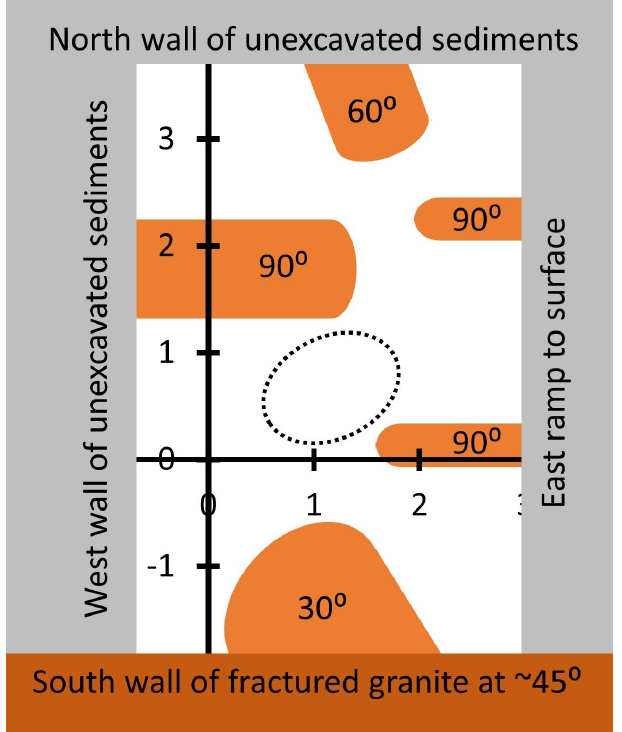
Figure 10. The layout of granite rocks (brown) and sediment walls (gray) at depth of ~ 6.3 to 6.5 m. The scale is in meters and the angles are between the vertical and the normal to the largest-area surface. The origin is directly below the center of the original impact crater on the surface with an estimated accuracy of +/- 0.3 m. The dotted ellipse shows the approximate projection of the shat- tered rock found in the 2018 excavation at 4.7-m depth to the 6.4-m depth shown here. We could not determine whether the mixture of rocks and slabs at different angles to the horizontal, as shown in Figure 10, were characteristic of the site before the 1985 event or were caused by that event. Additional excavation directly beneath the grouping of fractured rock at ~4.7-m depth was blocked by large boulders or displaced slabs around that volume. These obstacles were too large to move with available equipment. In addi- tion, the excavation from 4.8 m to 6.3 m had nearly vertical walls, which introduced a safety risk and precluded more excavation within the limitations of the project. 3.6. Potential for Independent Validation of the 1985 Event The force equation for a high-velocity body with instantaneous radius r m , mass m , and velocity v , moving through a fluid of density ρ p with a drag coefficient K ≈ 1, is 2 (3) MQNs have a velocity-dependent interaction radius [21] that is equal to the radius of their magnetopause